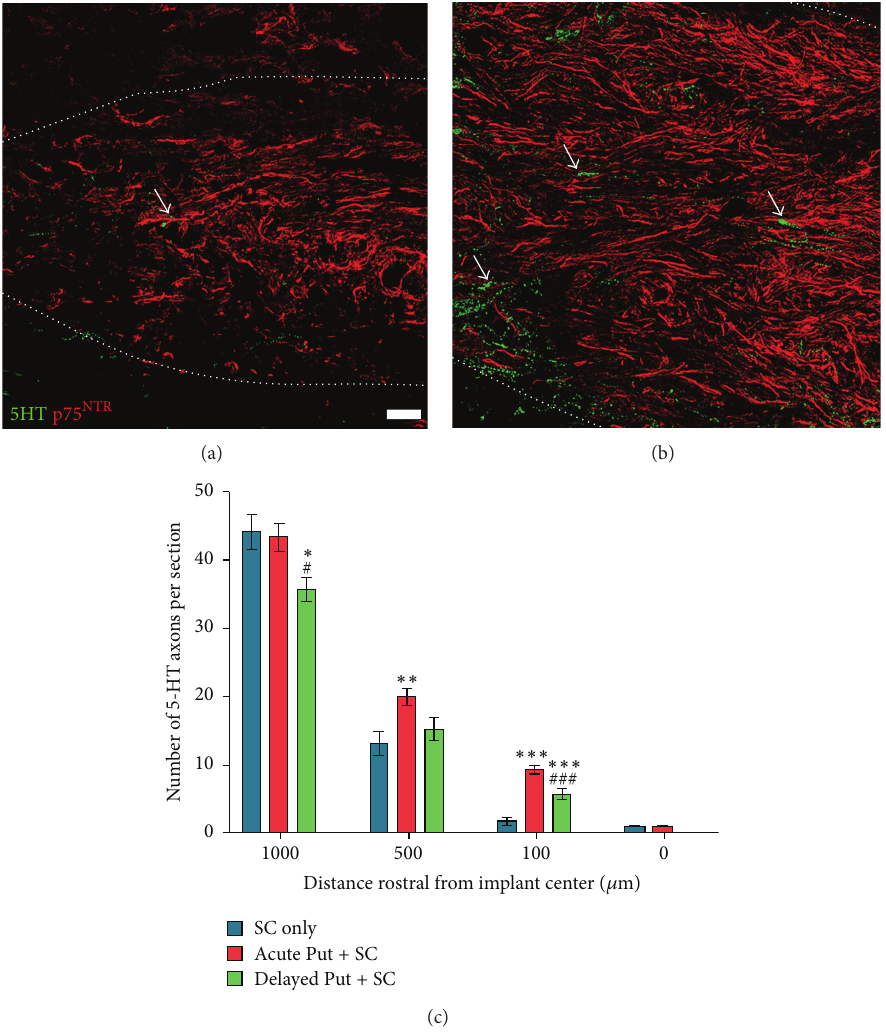
Figure 4: Putrescine supplementation enhances serotonergic axon numbers within the SC implant. Immunochemical staining for serotonergic axons (green, representative examples indicated by white arrows) shows many more axons within the rostral part of the SC implant (identified by p75 labeling, red) following (b) acute putrescine delivery compared to (a) when vehicle is given. Scale bar = 20 𝜇 m. Dotted white lines indicate the extent of the SC implant. (c) Stereological analysis shows a significant increase in 5HT + axon numbers with putrescine; the greatest effects are seen further from the center of the SC implant (i.e., closer to rostral host cord SC implant interface) and with acute administration. Statistical significance indicated at ∗ 𝑝 < 0.05 , ∗∗ 𝑝 < 0.01 , and ∗∗∗ 𝑝 < 0.001 compared to the vehicle control group and # 𝑝 < 0.05 and ### 𝑝 < 0.001 compared to acute putrescine